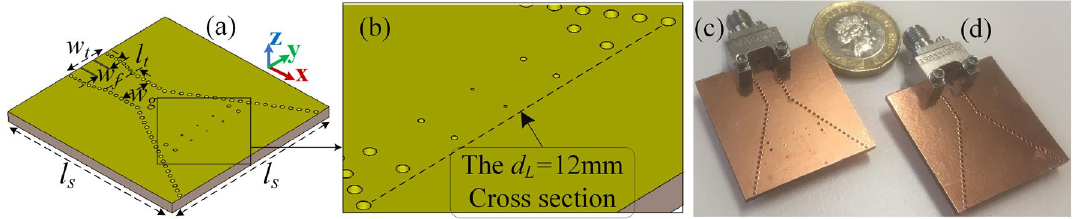
Figure 5. ( a ) Geometry of the proposed SIW H-plane horn loaded by the metal-via lens, ( b ) the lens pattern in a larger scale, ( c ) the fabricated loaded structure, ( d ) the fabricated conventional SIW H-plane horn.